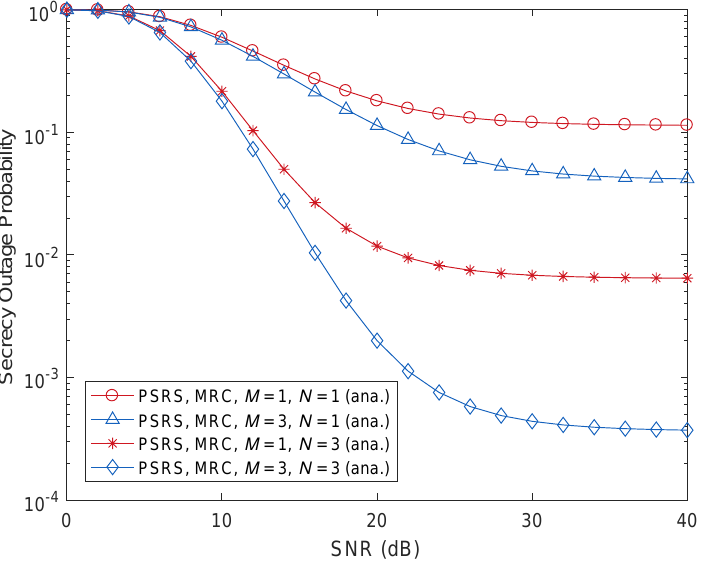
Figure 9. Illustration of the impact of the number of sources, M , and the number of relays, N , on the secrecy outage probability as a function of the signal-to-noise ratio (SNR), where d SR = 0.5, MER = 30 dB and R th = 3